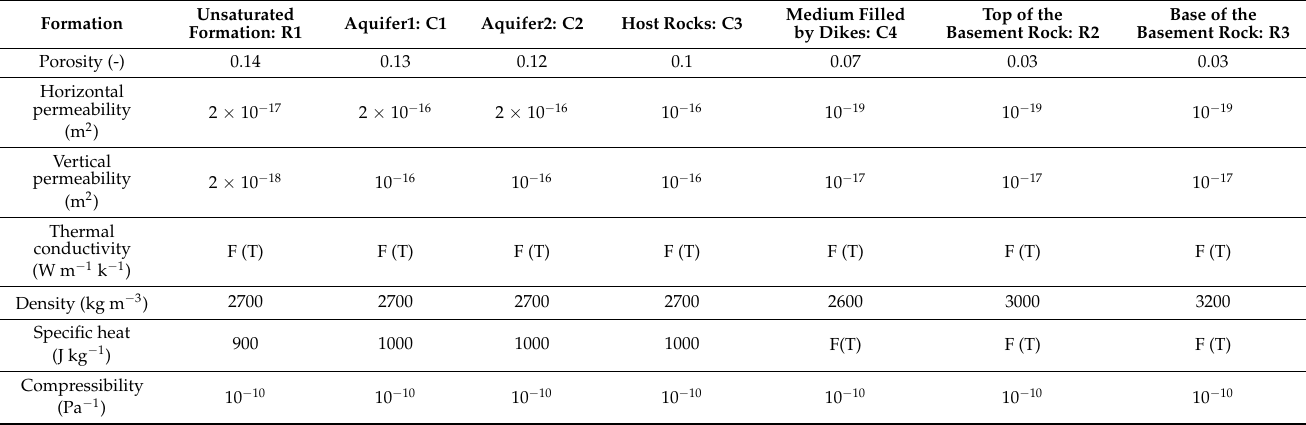
Table 1. Thermo-hydraulic properties for the base case (scenario